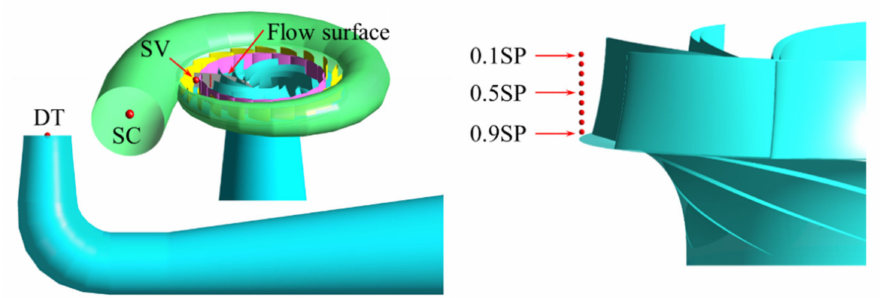
Figure 7. Layout of monitoring points.